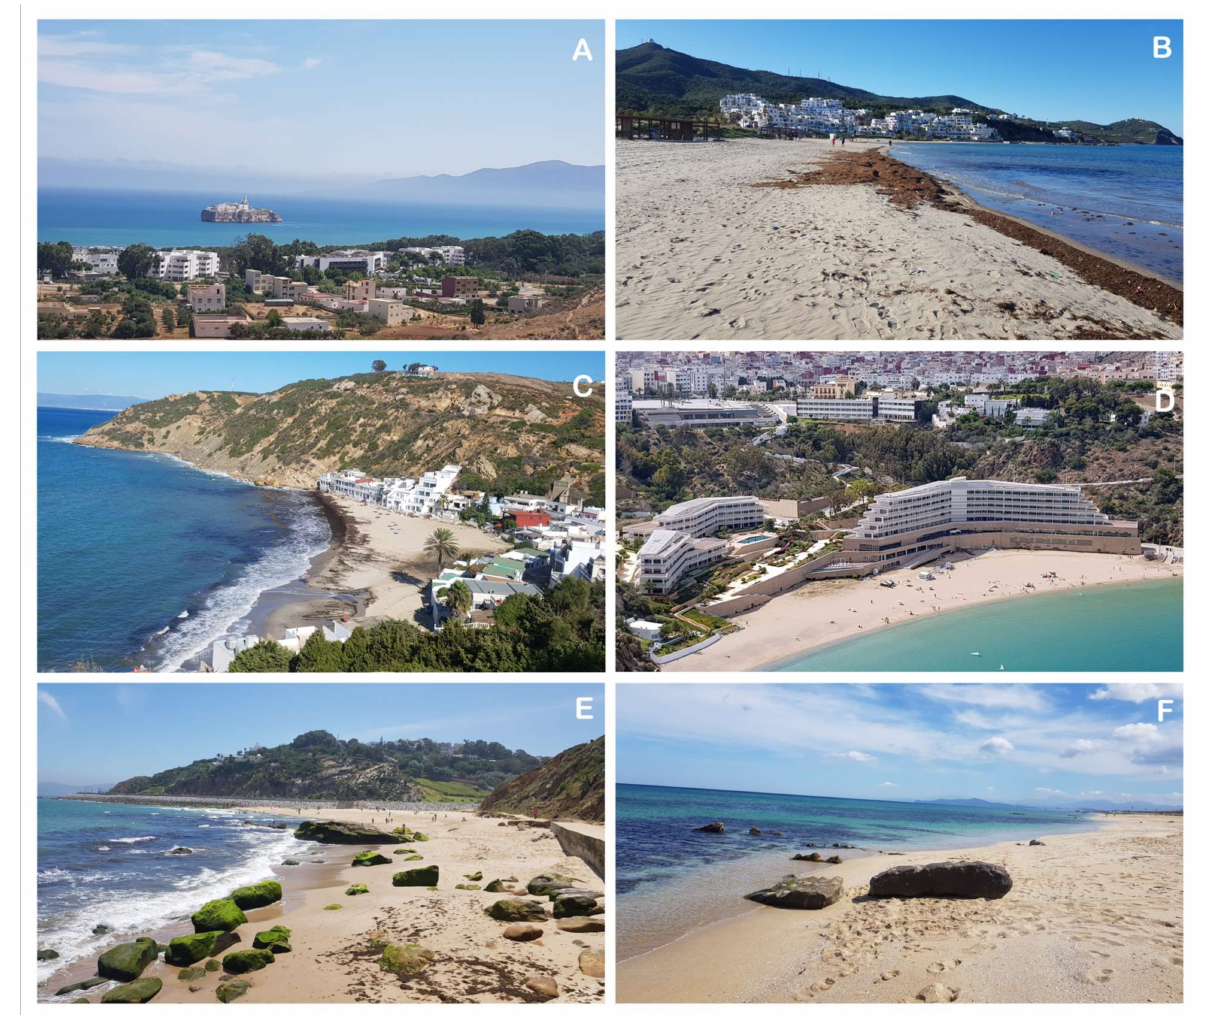
Figure 7. Examples of the characteristics of the physical and human parameters of Class II sites (( A ), Sfiha; ( B ), Cabo Negro), Class III (( C ), Playa Blanca; ( D ), Quemado), and Class IV (( E ), Marqala; ( F ),